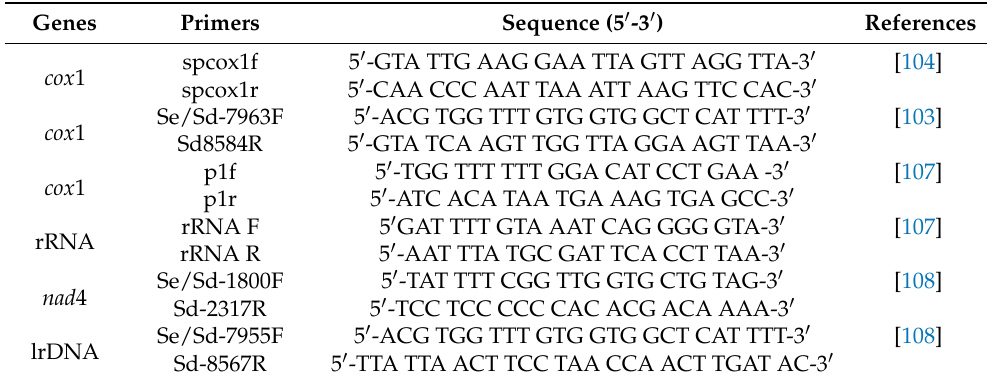
Table 4. S. decipiens molecular diagnosis. Genes Primers Sequence (5 (cid:48) -3 (cid:48)